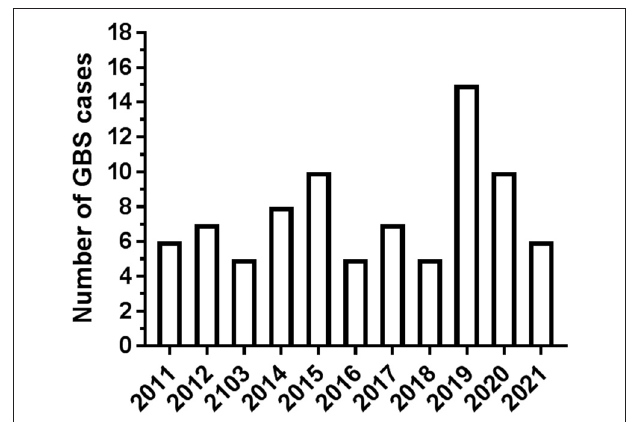
FIGURE 1 | Number of Guillain-Barré syndrome (GBS) cases per year.